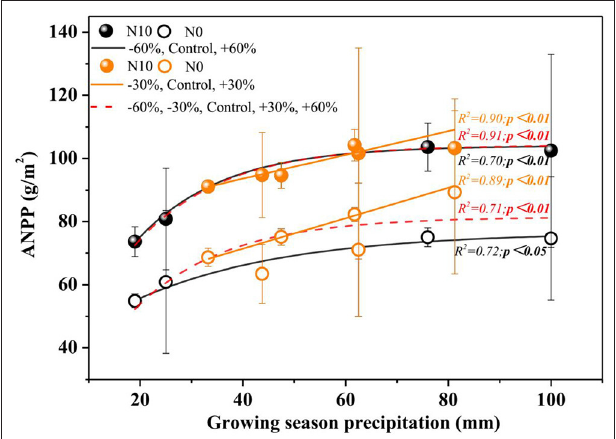
FIGURE 3 | Relationship between ANPP and amount of precipitation under two nitrogen levels. P-values smaller than 0.05 are presented in bold. Points are represented as mean ± 1 SE. The precipitation treatments include five levels, namely, − 60%, − 30%, Control, + 30%, and + 60% precipitation relative to the ambient level. N0 and N10 represent the treatments without N addition (Control) and with 10g N m − 2 yr − 1 application of nitrogen, respectively. The fitting function is shown in Supplementary Table 1 .